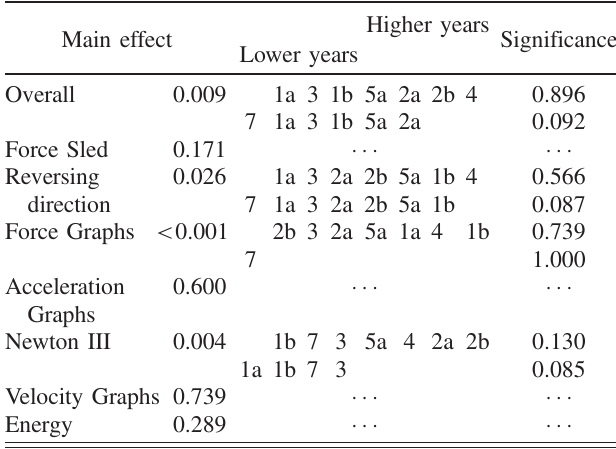
TABLE V. Results from one-way ANOVA and Post hoc comparisons between years at School 2. Numbers reported are p -values with the threshold for significance set at p ≤ 0 . 05 . The significance values indicate that statistically significant differences do not exist within the homogeneous subsets des- ignated as “ higher years ” or “ lower years. ” Years that appear twice belong to both homogeneous subsets.